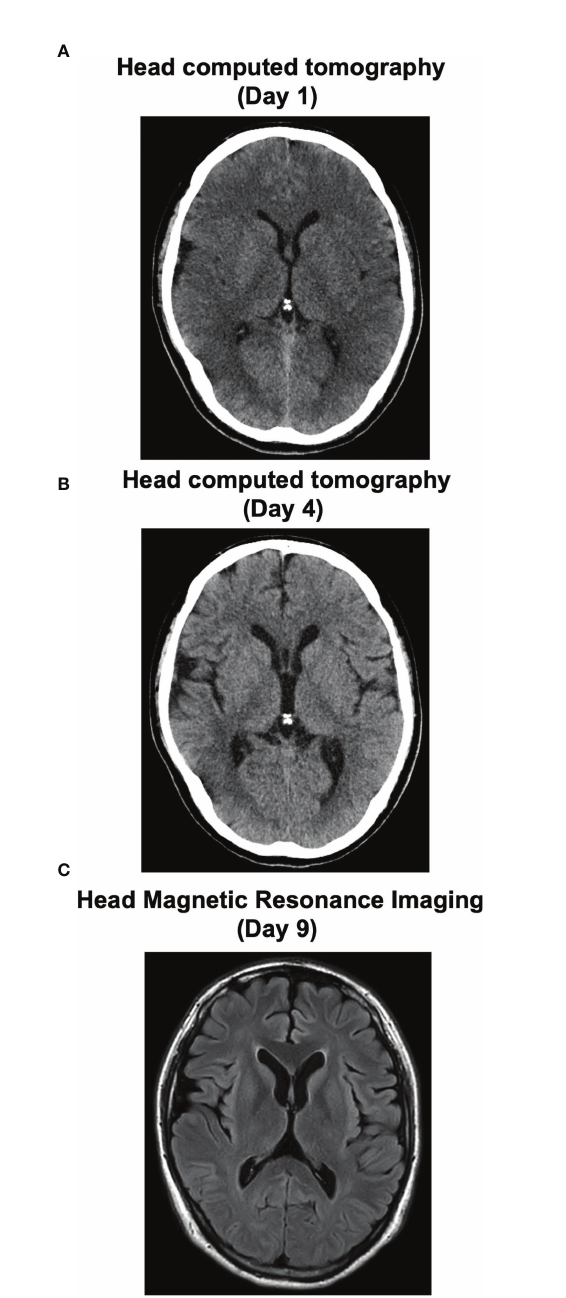
FIGURE 2 | Time course of cerebral edema in this subject on the image inspection. His severe cerebral edema on admission (A) was improved at day 4 (B) . At day 9, he was transferred from HCU to general ward. His head magnetic resonance imaging was normal (C)